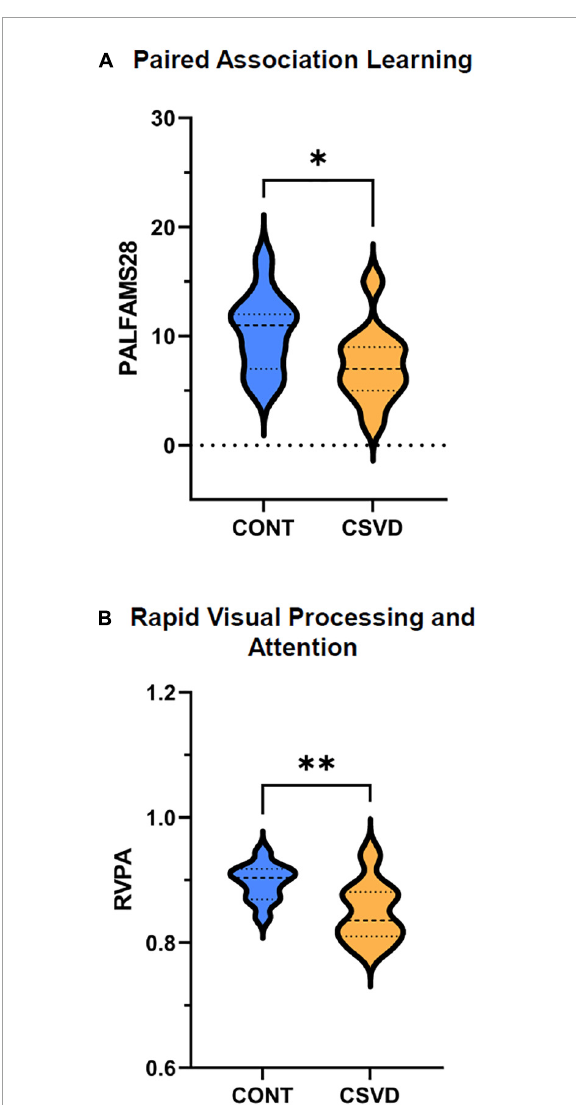
FIGURE1 Cognitive performance is impaired in older adults with cerebral small vessel disease (CSVD). (A) We observed a significant decrease in the Paired Associate Learning First Attempt Memory Score (PALFAMS28) in the patients versus age- and sex-matched elderly controls (CONT), evidenced as a significantly higher percentage of recalling the correct box at first attempt (two-sample unpaired t -test, p = 0.03, n = 11 per group). (B) We also observed a significantly decreased performance in the rapid visual processing and attention (RVPA) test (0 to 1 from poor to good performance; two-sample unpaired t- test, p = 0.007, CONT: n = 11, CSVD: n = 9) in participants with CSVD compared with CONT. Dashed line mark the median and dotted lines bound the interquartile range. * p < 0.05, ** p < 0.01.